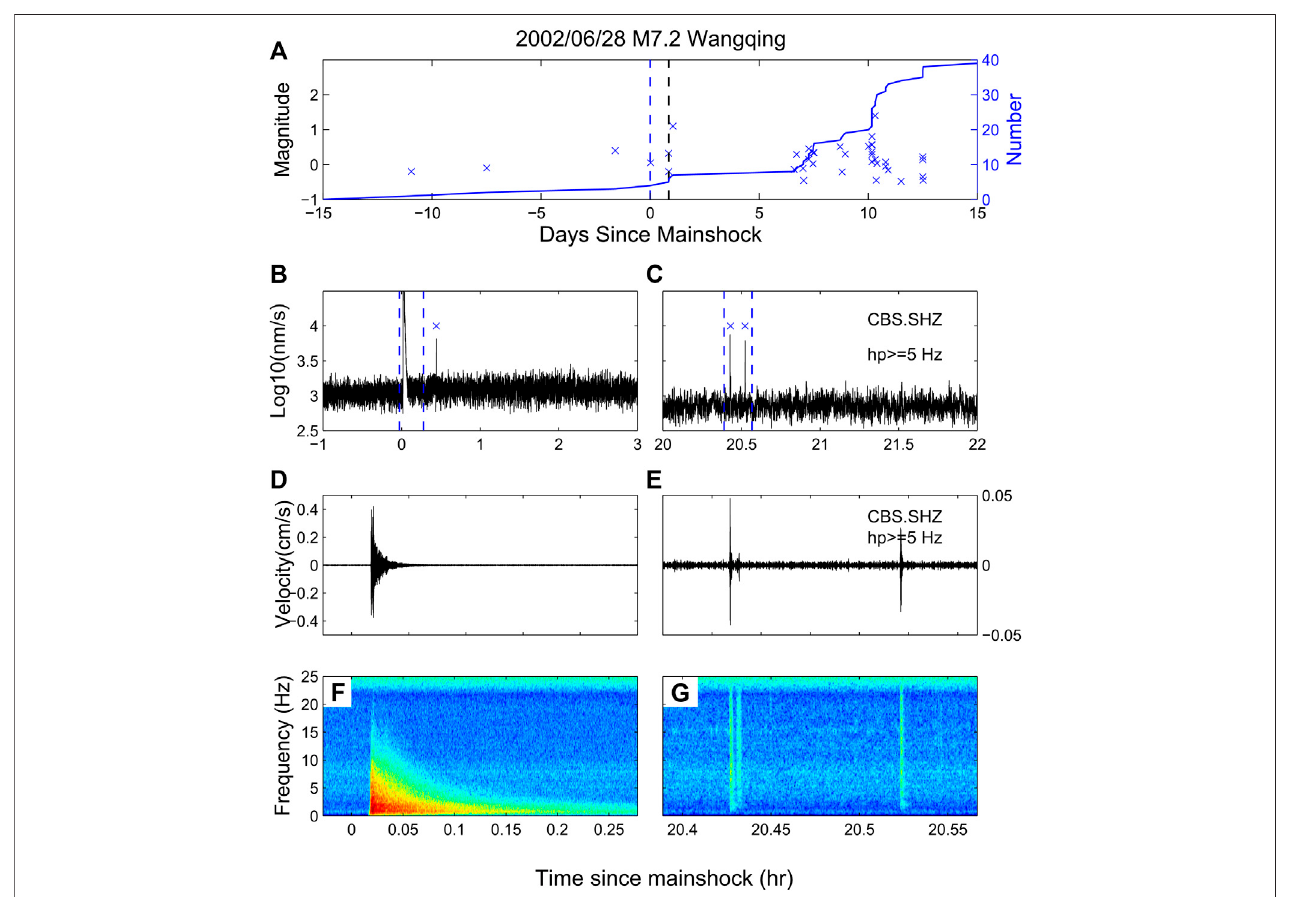
FIGURE 4 | (A) Seismicity within 15 days before and after the 2002 M 7.2 Wangqing earthquake. The crosses mark events listed in the newly detected catalogue, the blue curve shows the cumulative number of earthquakes, and the vertical blue lines indicate the time window plotted in (B) and (C) . (B,C) Envelope functions of the high-pass fi ltered 5 Hz waveform during and after the 2002 M 7.2 Wangqing earthquake. The newly detected earthquakes are marked as blue crosses. (D,E) Zoom-in plots of the areas between the blue dashed lines in (B) and (C) . (F,G) Spectrograms of (D) and (E) .